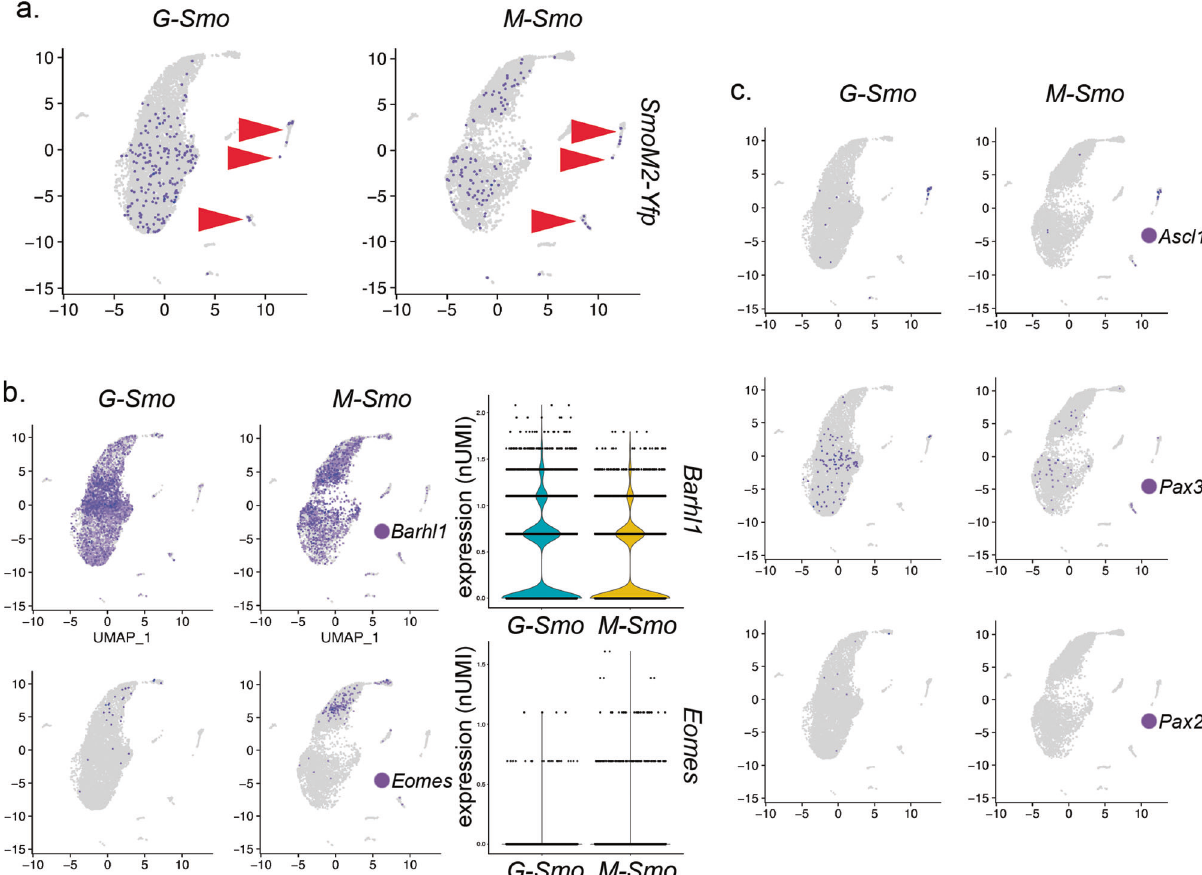
Fig. 4 Similar range of cell fates in G-Smo and M-Smo tumors. Feature plots showing expression of the indicated lineage markers, color-coded over the UMAP shown in (2D). a SmoM2-Yfp expression, denoting the SmoM2 -activated lineage, was distributed similarly in both G-Smo and M-Smo tumors. Arrowheads point to glial clusters. b Feature and violin plots show increased Barhl1 + cells in G-Smo tumors and increased Eomes in M-Smo tumors. c Feature plots show no signi fi cant differences in Ascl1 , Pax2 , or Pax3 in G-Smo tumors versus M-Smo